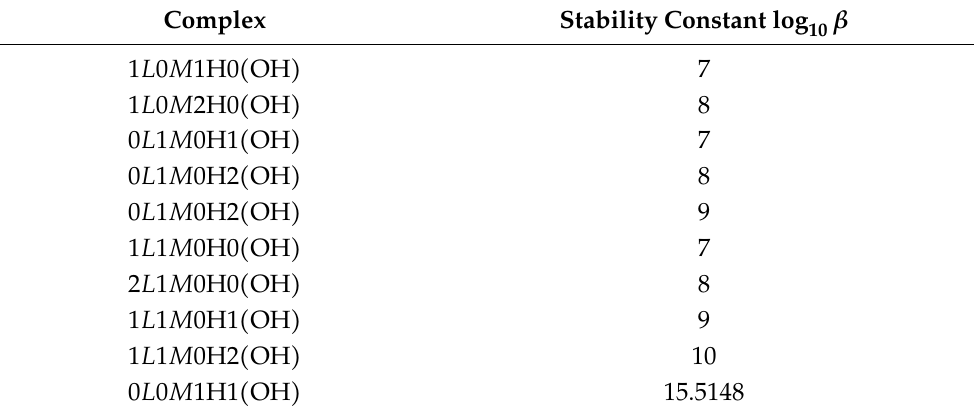
Table 1. Complexes for the software test with moderate stability